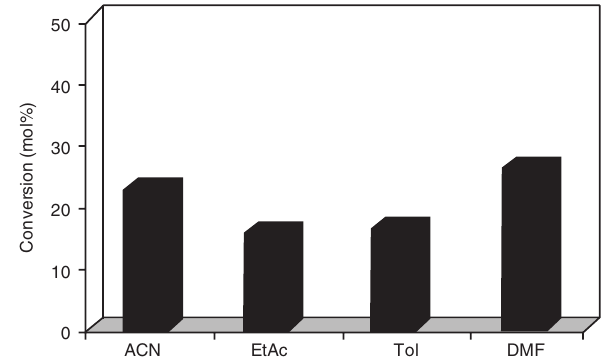
Figure 3 Solvent screening in the 0.5% Co/Al-SBA-15 catalyzed microwave-assisted oxidation of benzyl alcohol with hydrogen peroxide. Reaction conditions: 2 ml solvent, 0.2 ml benzyl alcohol, 0.3 ml H O (50% v:v) and 0.050 g catalyst, microwaves, 300 W, 2 2 70–80 ° C, 5 min reaction.